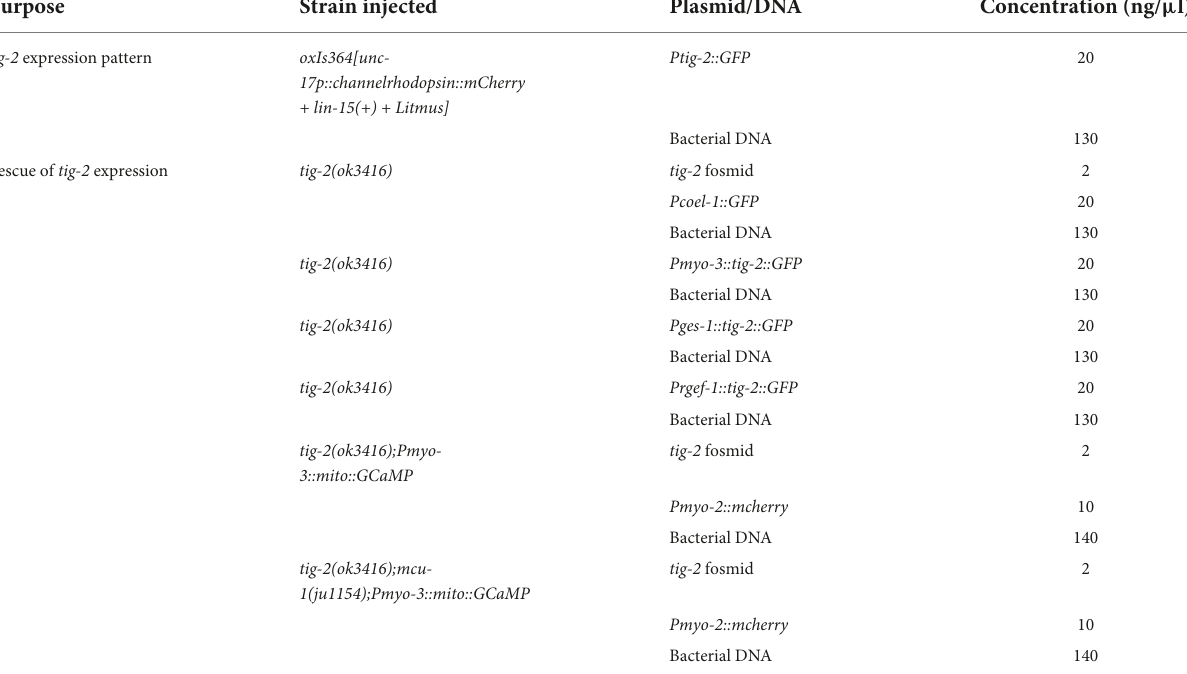
TABLE 2 Plasmids mix used for